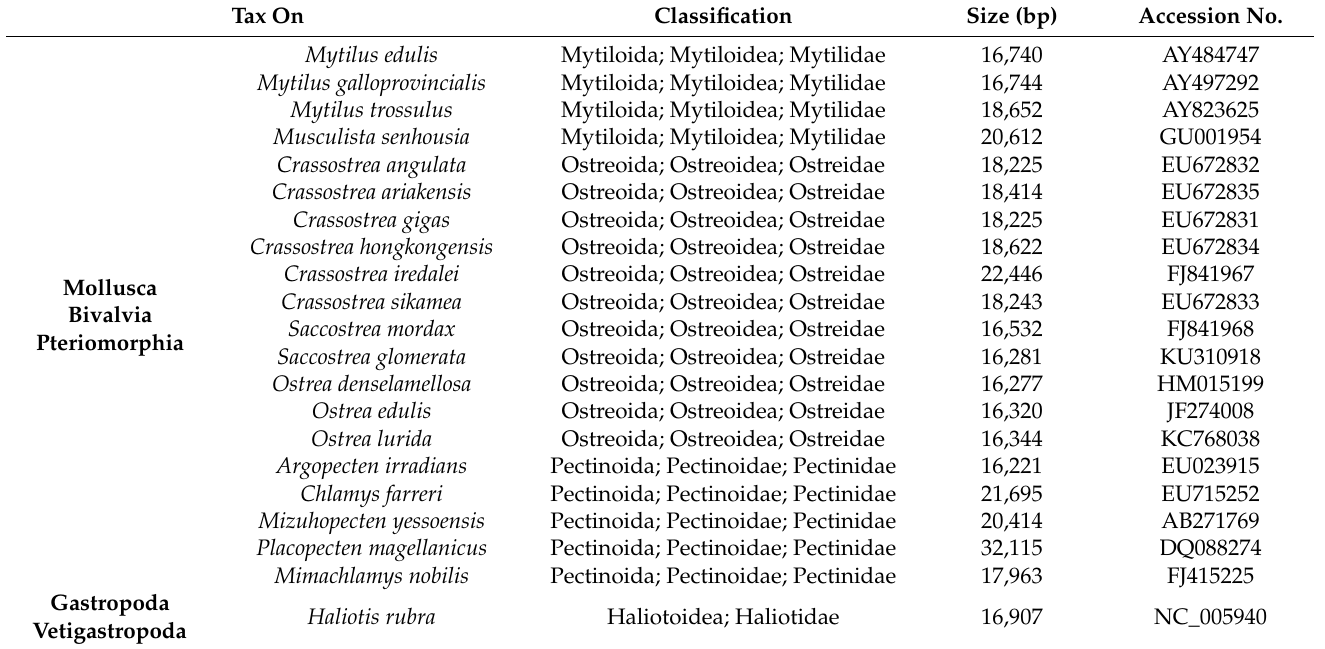
Table 1. List of complete mt genomes used in this